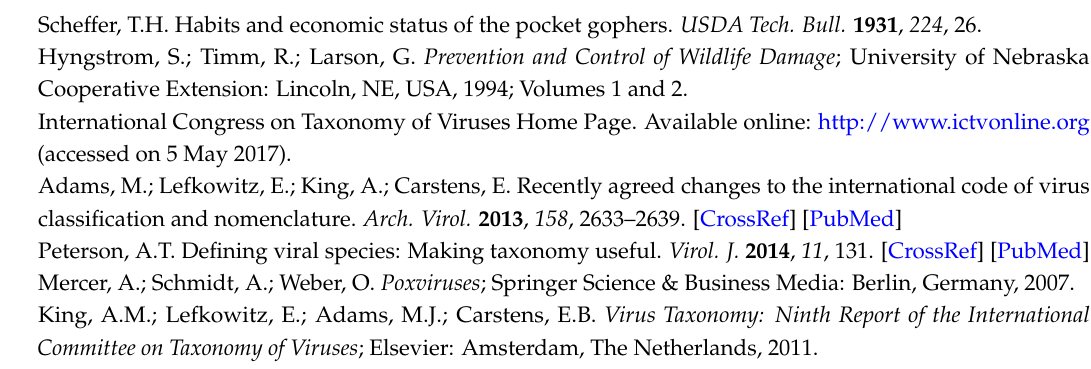
Figure S1: Dataset 1 RAxML Results; Figure S2: Dataset 2 RAxML Results; Table S1: Average uncorrected p-distance bottom left, patristic distance top right for dataset 1 for all examined taxa; Table S2: Average uncorrected p-distance bottom left, patristic distance top right for dataset 2 for all examined taxa; Table S3: Average intra-lineage genetic distance within each group, calculated using uncorrected-p distance in